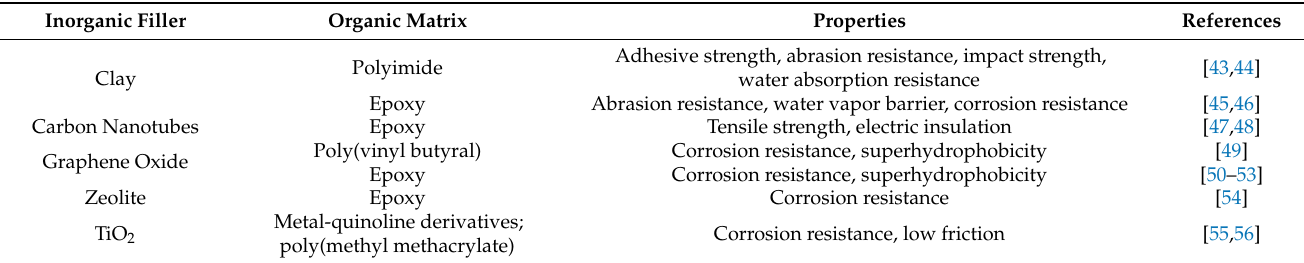
Table 1. Inorganic fillers other than silica nanoparticles (SNPs) used in hybrid materials for coating applications. Inorganic